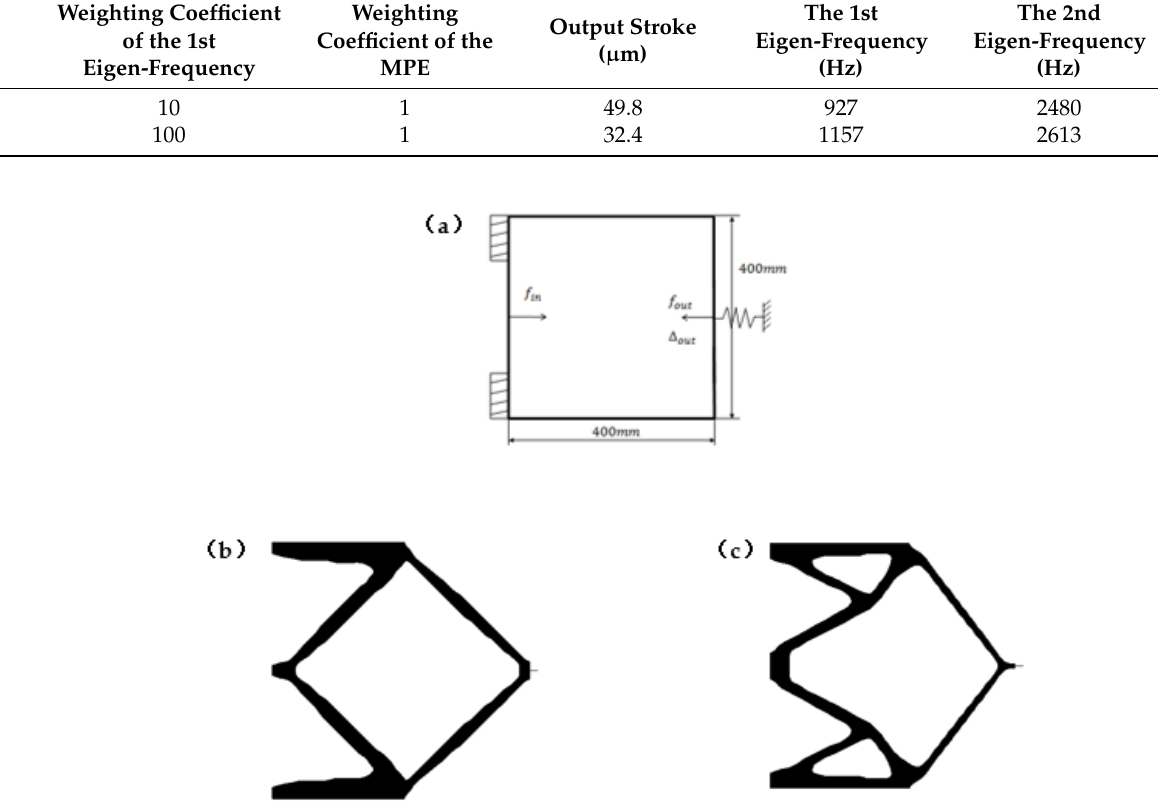
Figure 4. ( a ) Design domain and boundary of the inverter mechanism; ( b ) continuous optimized layout with weighting coefficient 10 of the 1st eigen-frequency; ( c ) continuous optimized layout with weighting coefficient 100 of the 1st eigen-frequency.